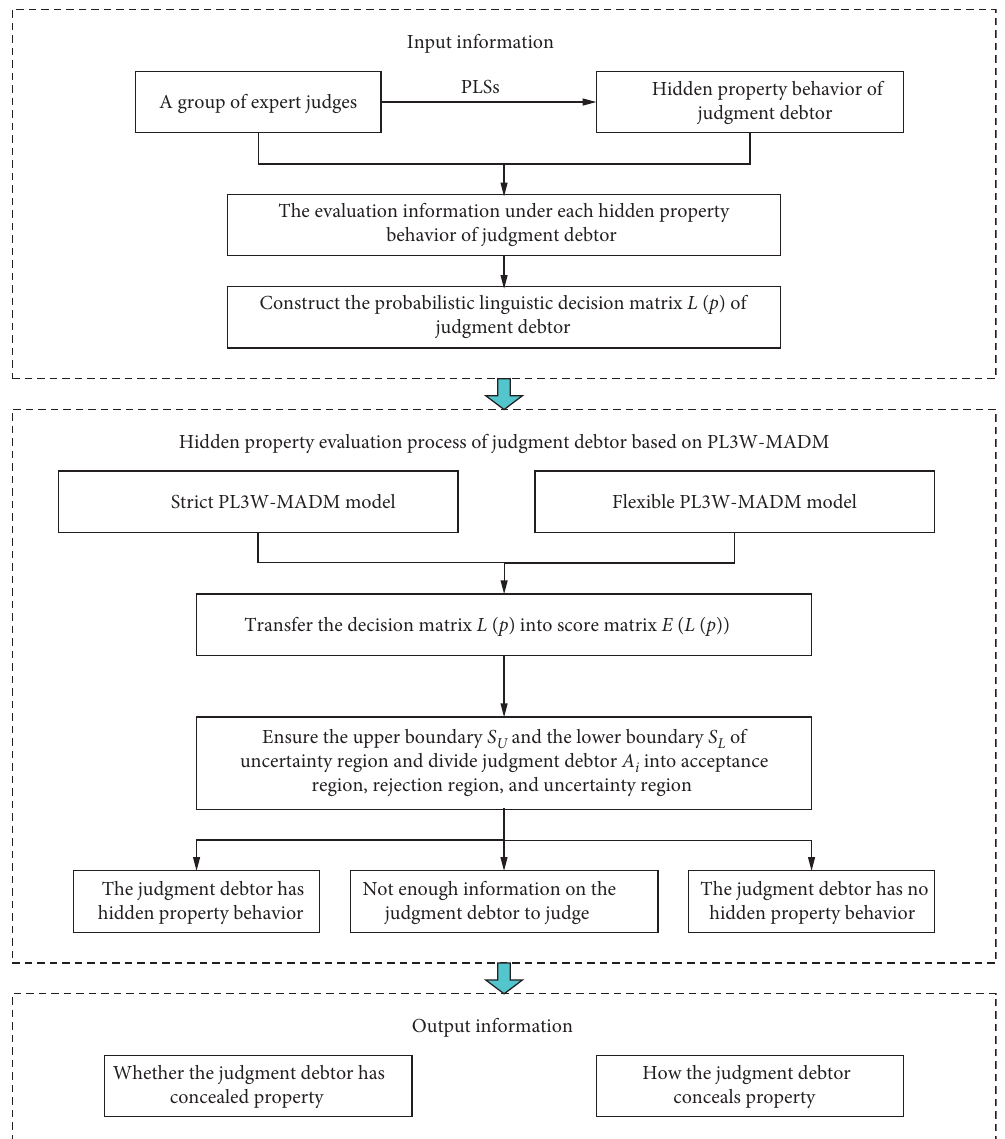
Figure 1: The flowchart of the hidden property evaluation based on the PL3W-MADM